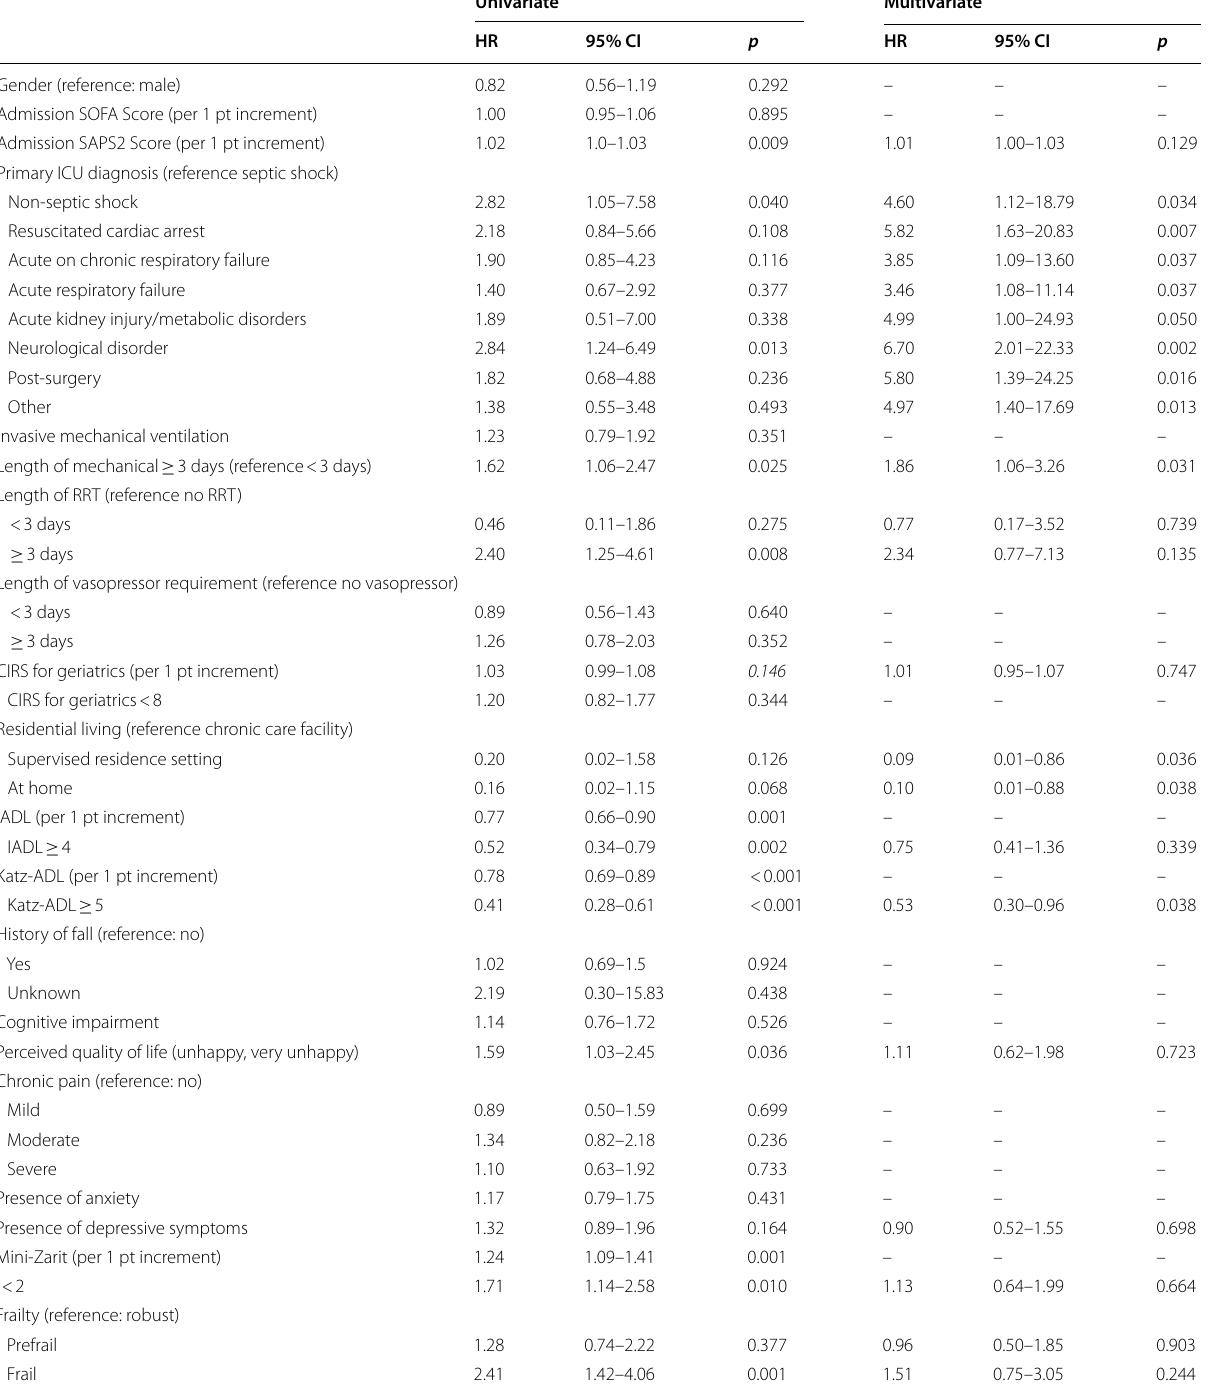
Table 5 Determinants associated with one-year mortality among patients who survived to hospitalization using Cox cause-specific